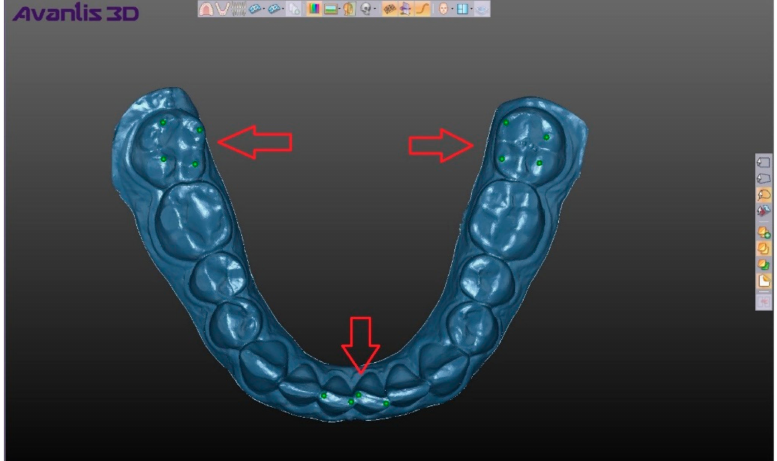
Figure 6. Places for received numeric value of divergence (noted with green